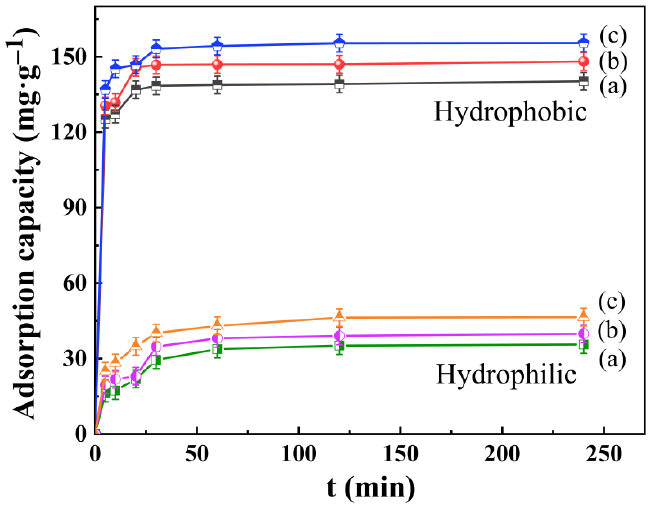
Figure 10. Effect of hydrophilic and hydrophobic ZrO 2 -SiO 2 xerogels at various adsorption temperatures ( a ) 25 °C, ( b ) 35 °C, and ( c ) 45 °C on the adsorption capacity of RhB (pH = 7, RhB concentration = 140 mg·L − 1 ).